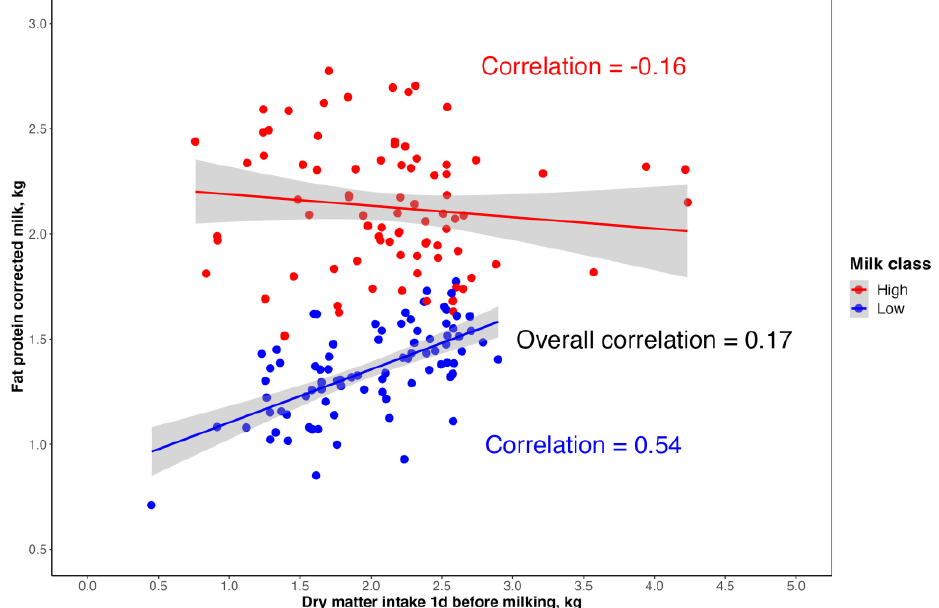
Figure 3. Relationship between fat- and protein-corrected milk (FPCM) and dry matter intake measured the day before milking. Red indicates high-yielding ewes, whereas blue indicates low-yielding ewes. The lines indicate the trend line from the linear model.